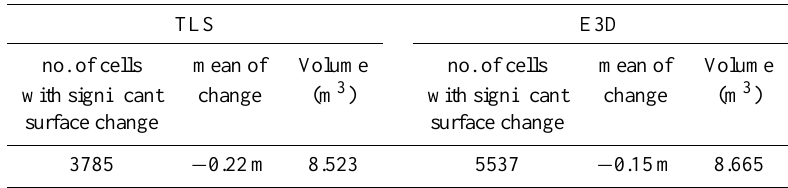
Figure 5. Model results of the statistical-based erosion model. Averaged values for one month for this study (left) and for the study by Neugirg et al. (2015) (right). Table 2. Surface changes acquired with TLS (left) and E3D (right).